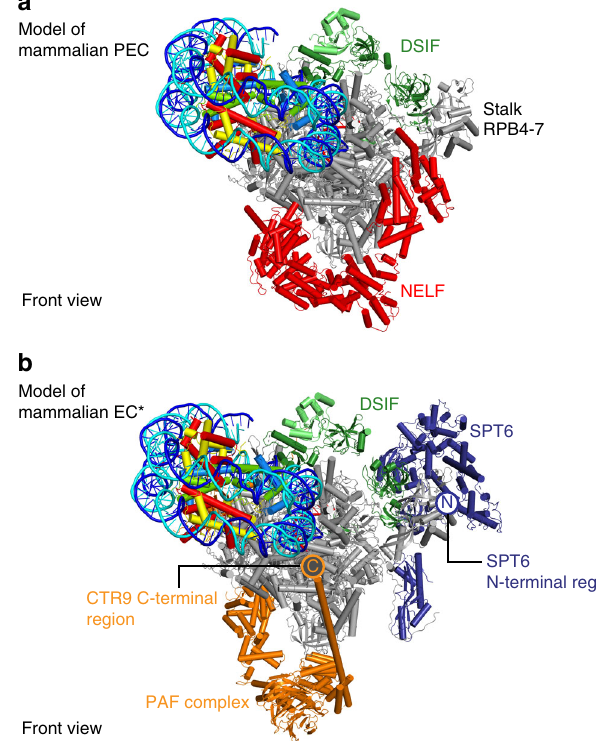
Fig. 3 Accommodation of elongation factors. a Superposition of Pol II – NCP structure with the mammalian paused elongation complex PEC (PDB code 6GML) provides the location of DSIF and NELF. b Superposition of the mammalian activated elongation complex EC* (PDB code 6GMH) provides the location of PAF1 complex (PAF) and